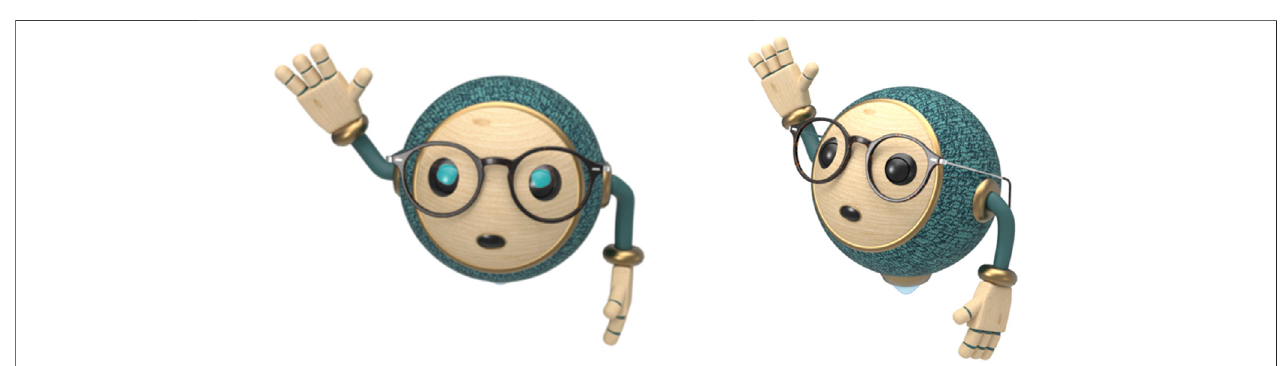
FIGURE 3 | The fi nal sketch of